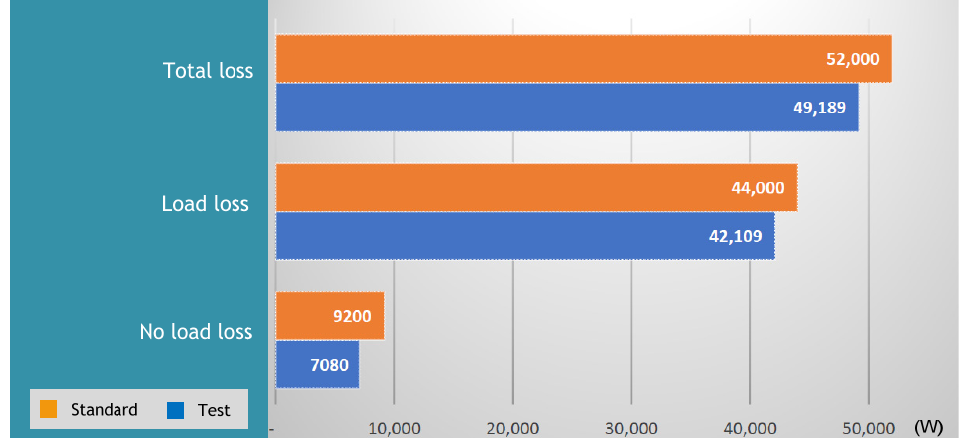
Figure 13. The loss comparison between IEC 60076 standard and transformer test result.